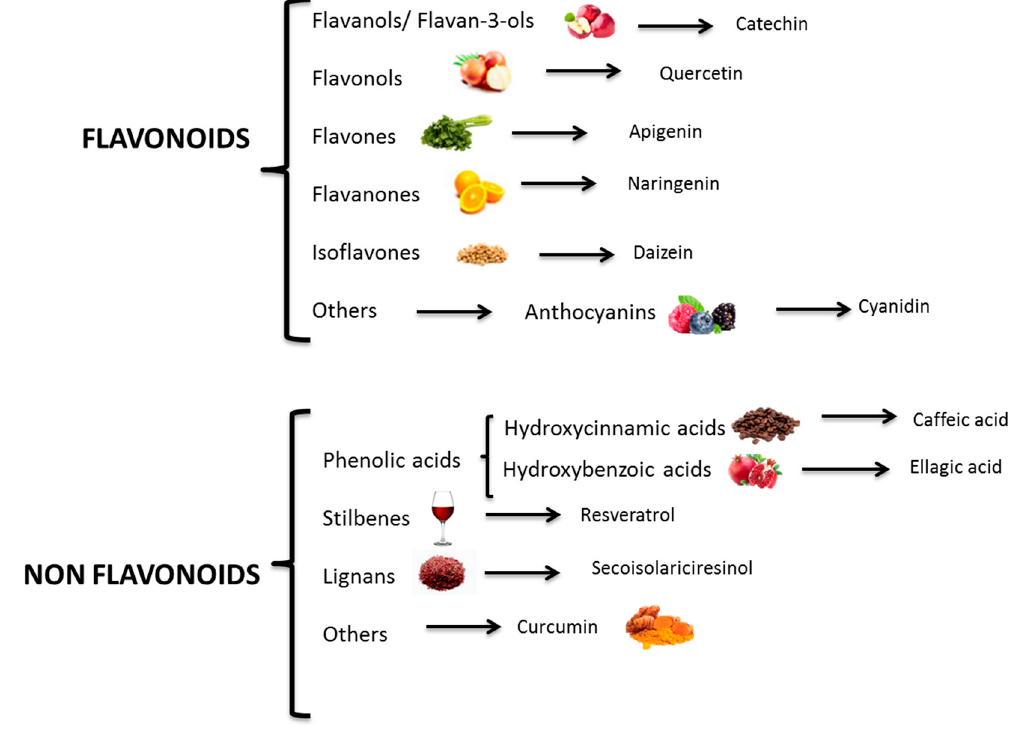
Figure 3. Polyphenols